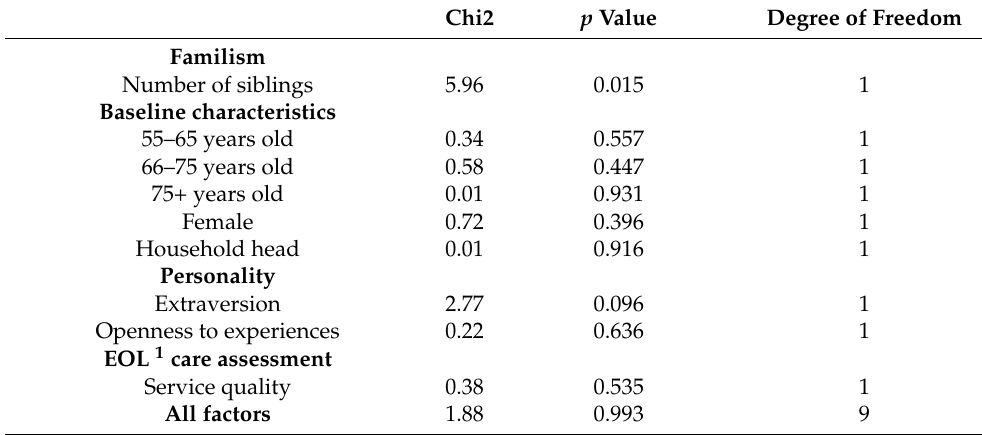
Table A3. Brant test result for ordered logistic